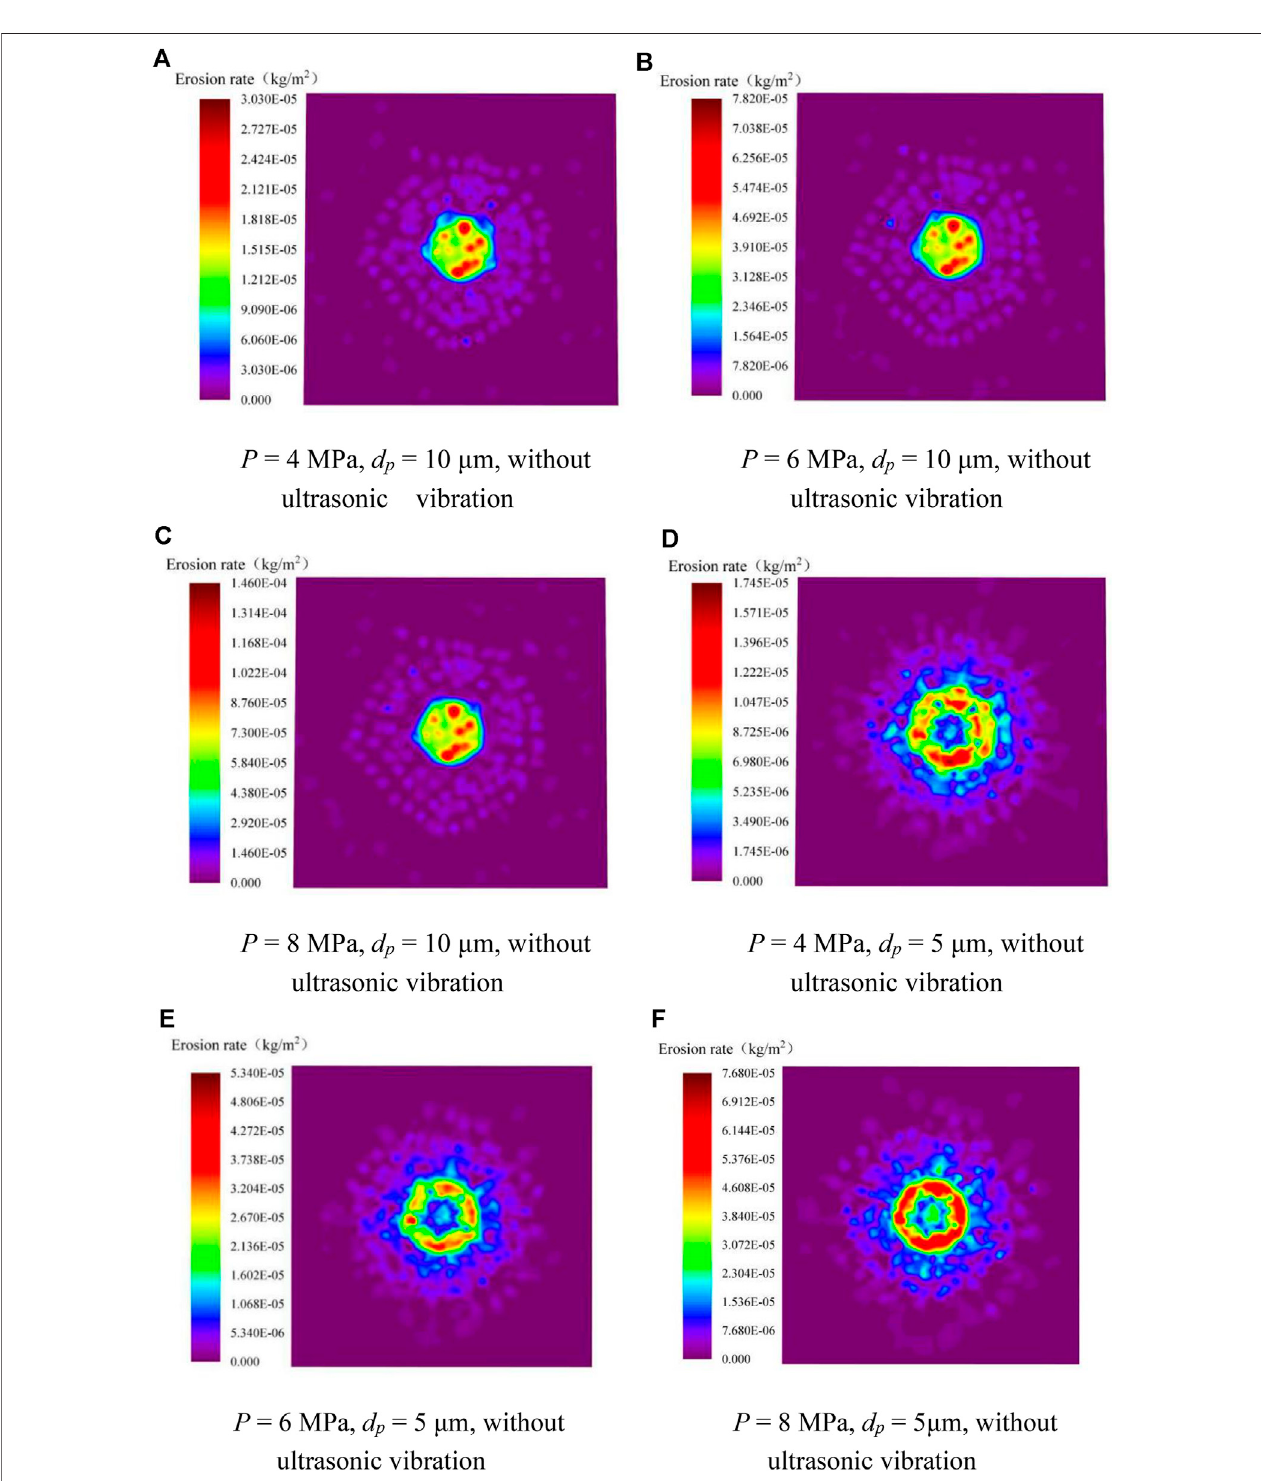
FIGURE 10 | Cloud map of material erosion rate on the workpiece surface. (A) P = 4 MPa, d p = 10 μ m, without ultrasonic vibration, (B) P = 6 MPa, d p = 10 μ m, without ultrasonic vibration, (C) P = 8 MPa, d p = 10 μ m, without ultrasonic vibration, (D) P = 4 MPa, d p = 5 μ m, without ultrasonic vibration, (E) P = 6 MPa, d p = 5 μ m, without ultrasonic vibration, (F) P = 8 MPa, d p = 5 μ m, without ultrasonic vibration, (G) P = 4 MPa, d p = 5 μ m, with ultrasonic vibration, (H) P = 6 MPa, d p = 5 μ m, with ultrasonic vibration, (I) P = 8 MPa, d p = 5 μ m, with ultrasonic vibration.